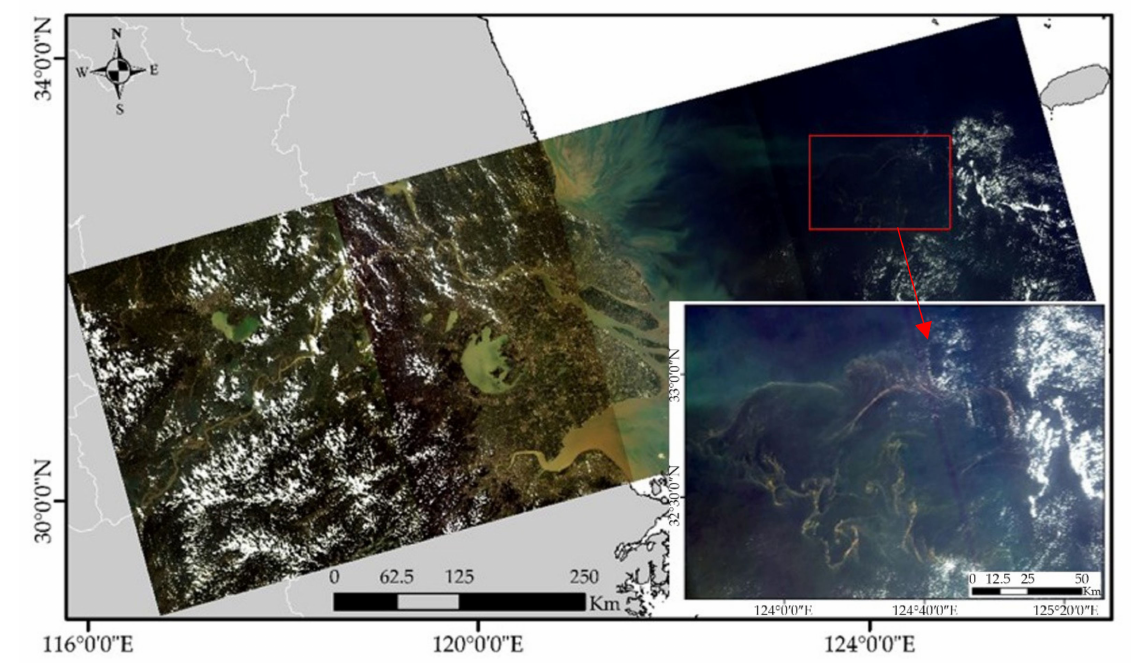
Figure 11. Rayleigh − corrected reflectance image calculated by Tong. The red box is the red tide area, and the image at the right bottom is the corresponding zoomed − in image.